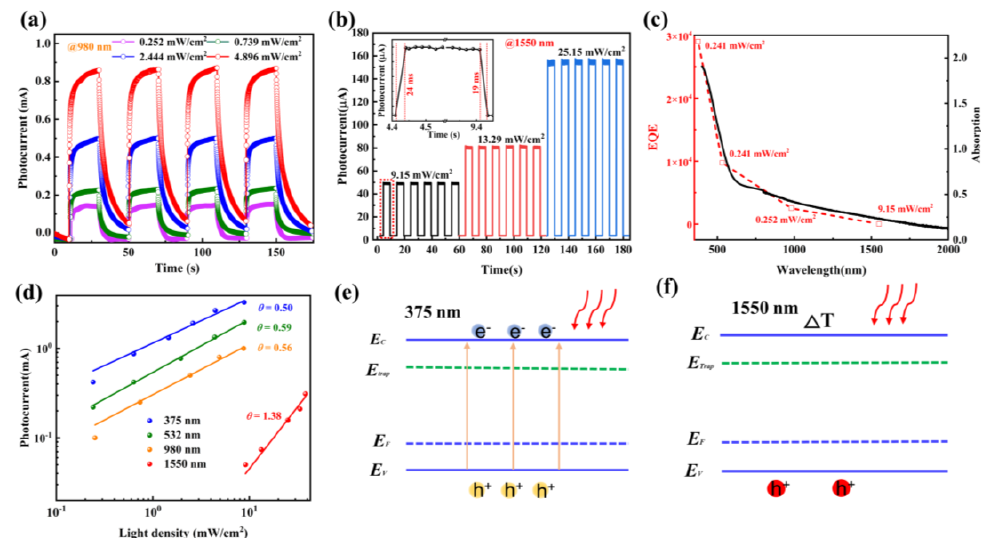
Figure 4. Time−dependent photocurrent of the photodetector at different incident light wavelengths of ( a ) 980 nm and ( b ) 1550 nm under various incident light power densities. ( c ) Absorbance spectrum of the SnS nanoflakes/graphene heterostructure and the spectral distribution of EQEs of the SnS nanoflakes/graphene photodetector. ( d ) Plot of photocurrents of the photodetector as a function of light power density under different laser wavelengths. Inset ( d ): Single−cycle dynamic response curve under 1550 nm; excitation power: 9.15 mW/cm 2 . Mechanism of generating photogenerated carriers based on photoconductivity effects ( e ) and photothermal effects ( f ).